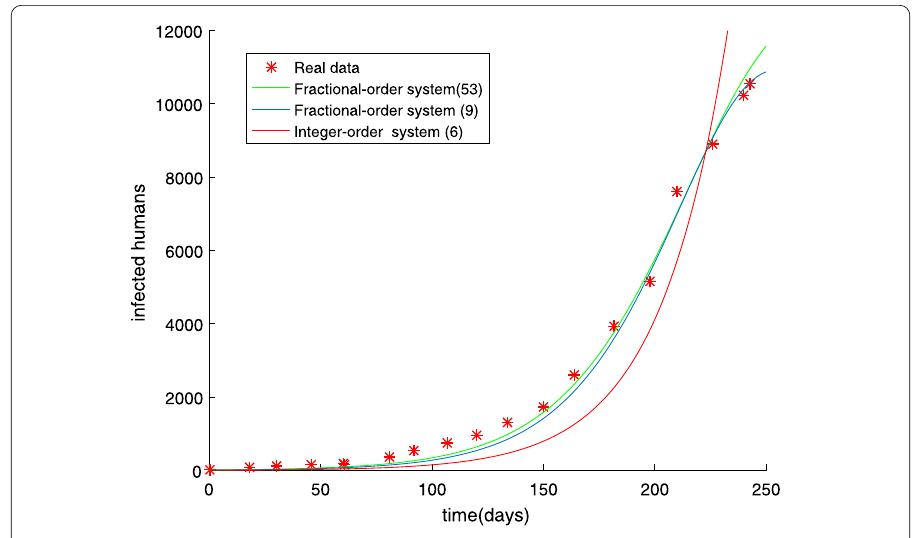
Figure 6 The fitting results of integer order system (6), fractional order Ebola system (9) which has the same order, and fractional order Ebola system (53) which has different orders with the real data. Their root-mean-square relative errors are g ( U ) = 1.0061, g ( U ∗ ) = 0.4146, and g ( U ∗ ) = 0.2744